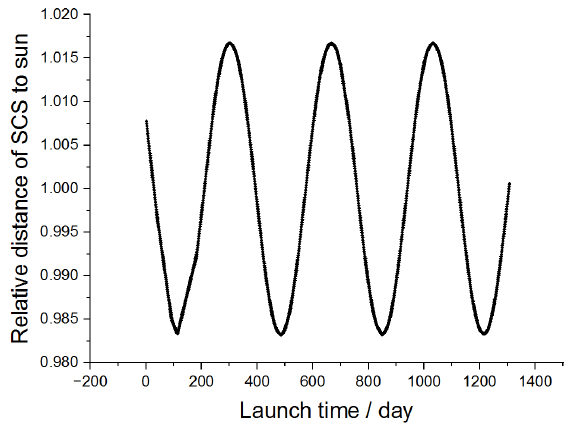
Figure 14. Time series of Sun-to-SCS distance.